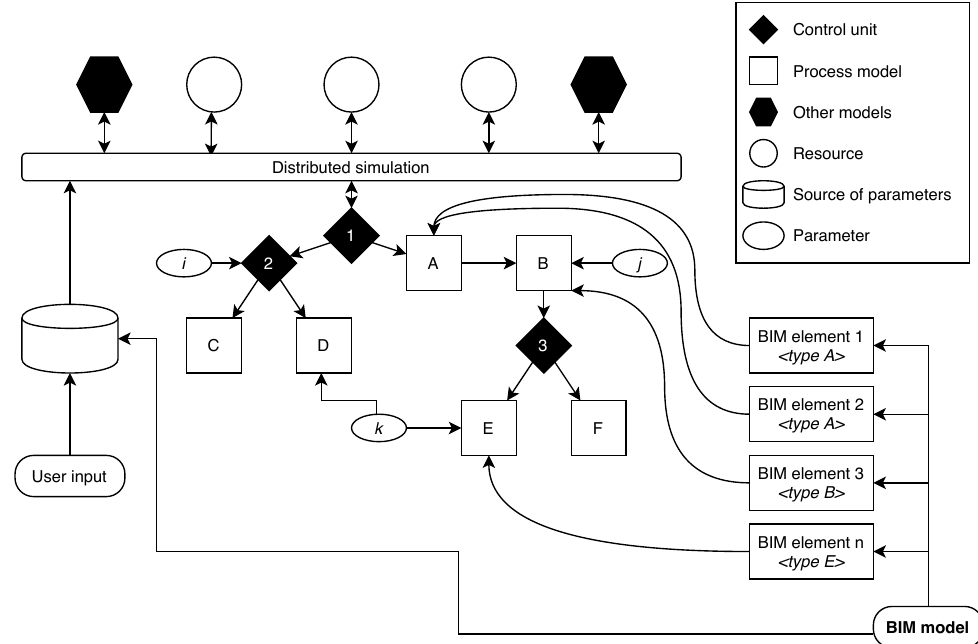
Figure 1. Adopted simulation approach.